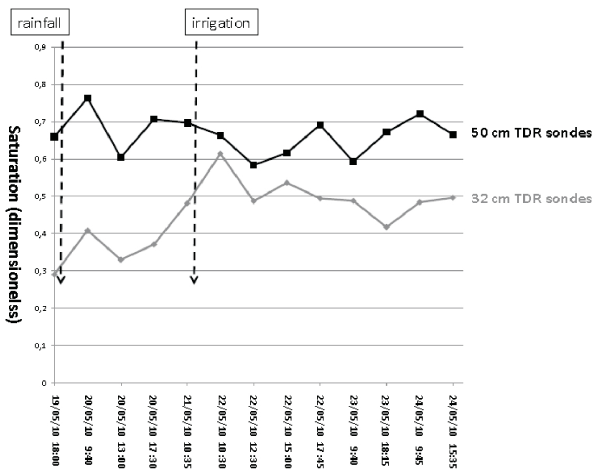
Fig. 7. Fallow plot soil saturation measured by fixed 50 and 32cm- deep TDR probes at different